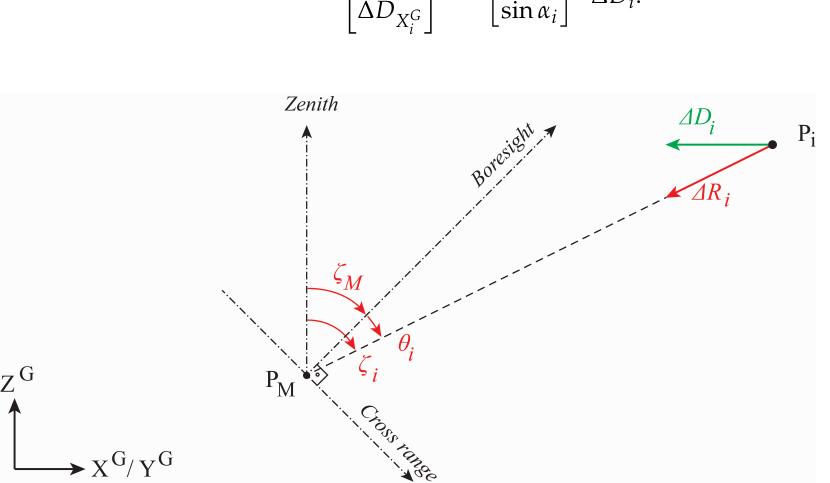
Figure 5. A vertical cross-section of the acquisition geometry showing the definition of the local coordinate system of a MIMO-SAR system with its relation to the three-dimensional global coordinate system. P M denotes the location of the MIMO-SAR sensor. The sensor’s boresight is tilted by an angle ζ M with respect to the zenith direction. The target object at location P i is at a slope distance R i in a direction deviating from the boresight by the cross-range angle θ i